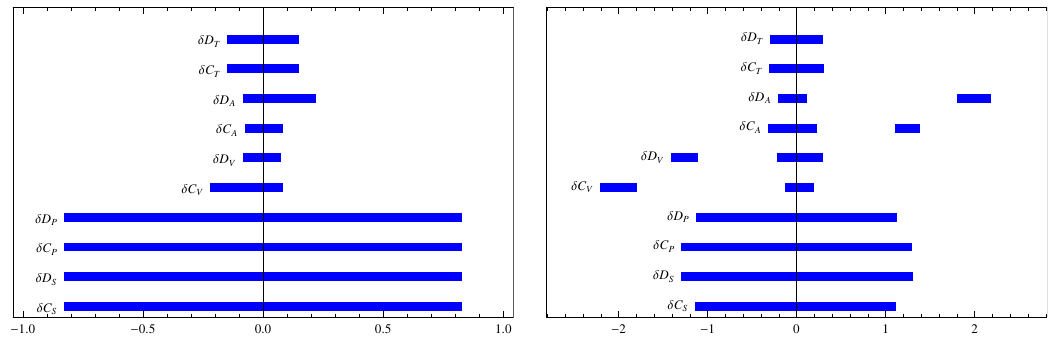
Figure 7 . Constraints on (cid:14)C a (cid:17) C a (cid:0) C SM and (cid:14)D a (cid:17) D a (cid:0) D SM from one-parameter (cid:12)tting of a a CHARM-II (left panel) and TEXONO (right panel). Blue bars represent 90% C.L. allowed values for (cid:14)C a and (cid:14)D a . There are two local minima for C A;V and D A;V in the (cid:12)t of TEXONO. The slightly more minimal global minimum is around (cid:0) 2 for C V , 0 for D V , 0 for C A and +2 for D A . In the SM, C V;A and D V;A are non-zero for Dirac neutrinos, while only C A and D A are non-zero for Majorana neutrinos. The plot assumes Dirac